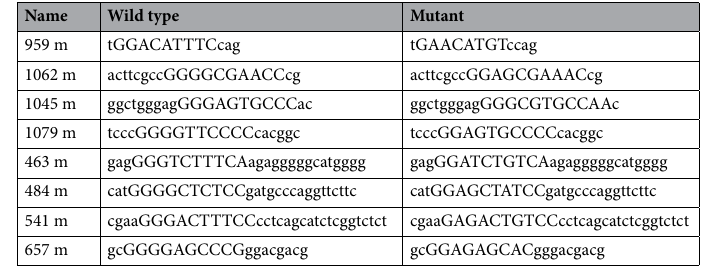
Table 1. Sequences of RELA binding sites of CD271 promoter